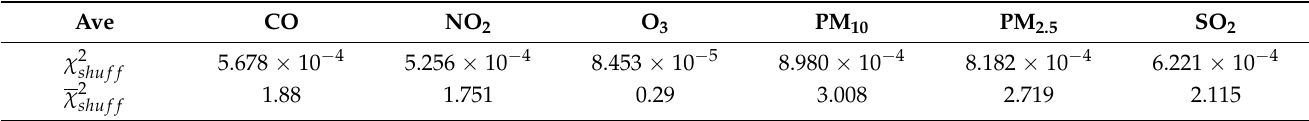
and χ 2 values for six pollutants in nine stations. shuf f shuf f